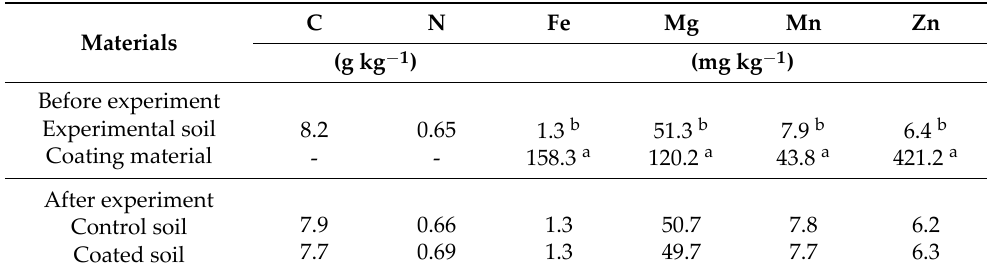
Table 1. The results of carbon, nitrogen, and extractable cation concentrations in before‑experiment soil, seed coating agent, and after‑experiment soil.